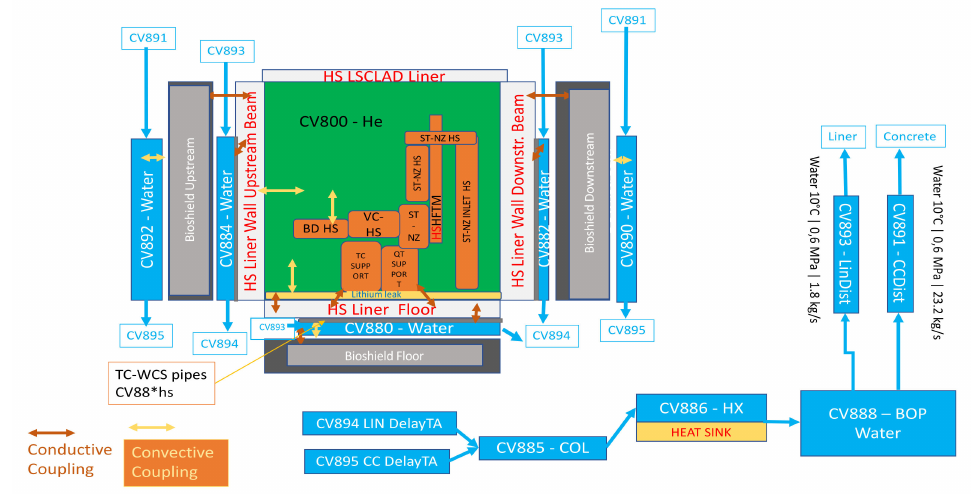
Figure 4. TC-WCS Melcor